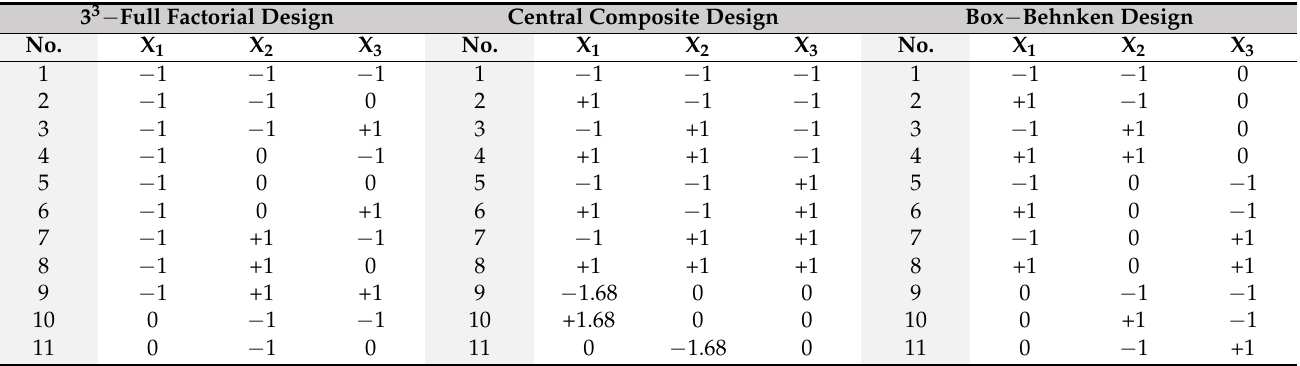
Figure 4. Illustration of 3 3 -Full factorial design ( a ), Central Composite Design with 3-factors ( b ), Box-Behnken design with 3-factors ( c ), and Doehlert design for 2-factors ( d ) and 3-factors ( e ). Table 7. The matrix of 3 3 -Full Factorial Design (3 3 -FFD), Central Composite Design (CCD), and Box-Behnken Design (BBD).